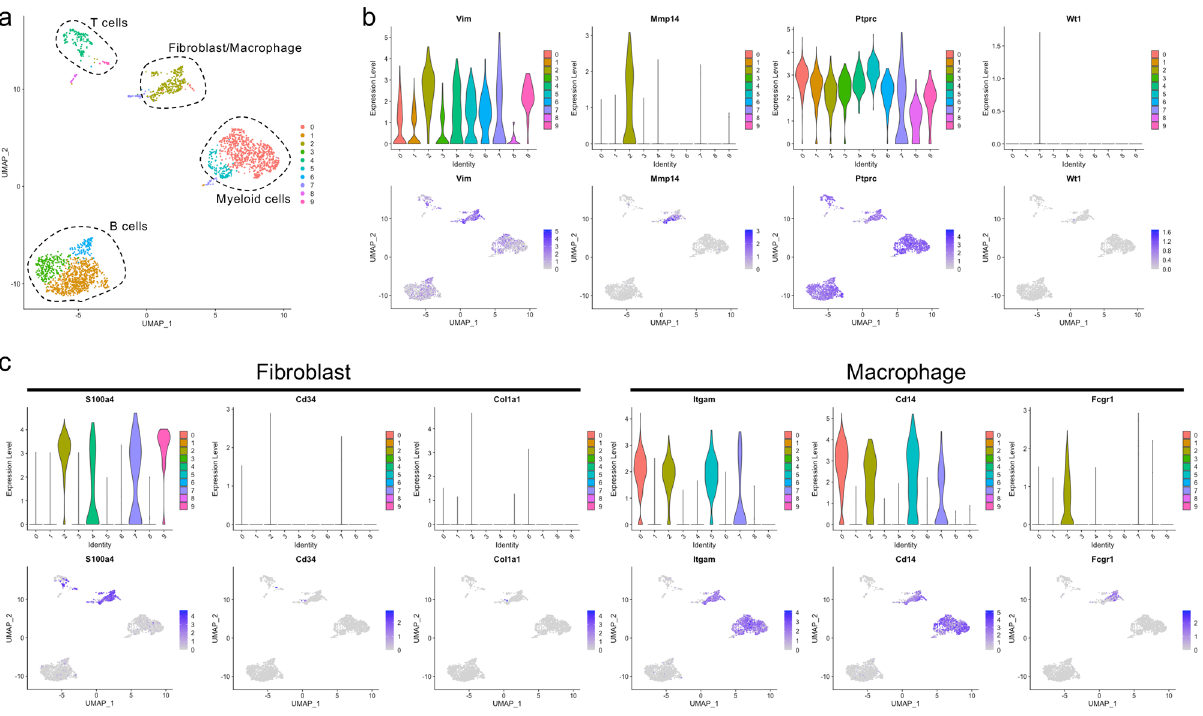
Figure 4. scRNA-Seq using omentum cells. ( a ) UMAP of scRNA-seq ( n = 2456 cells) revealed 10 clusters. ( b ) Violin (top) and feature plots (bottom) illustrating fibroblast markers Vim and Mmp14 , pan-hematopoietic marker Ptprc (also known as CD45 ), and adipose-derived stem cell marker Wt1 . ( c ) Violin (top) and feature plots (bottom) illustrating fibroblast markers S100a4, CD34 , and Col1a1 , and macrophage markers Itgam (also known as CD11b ), CD14 , and Fcgr1 (also known as CD64 ).